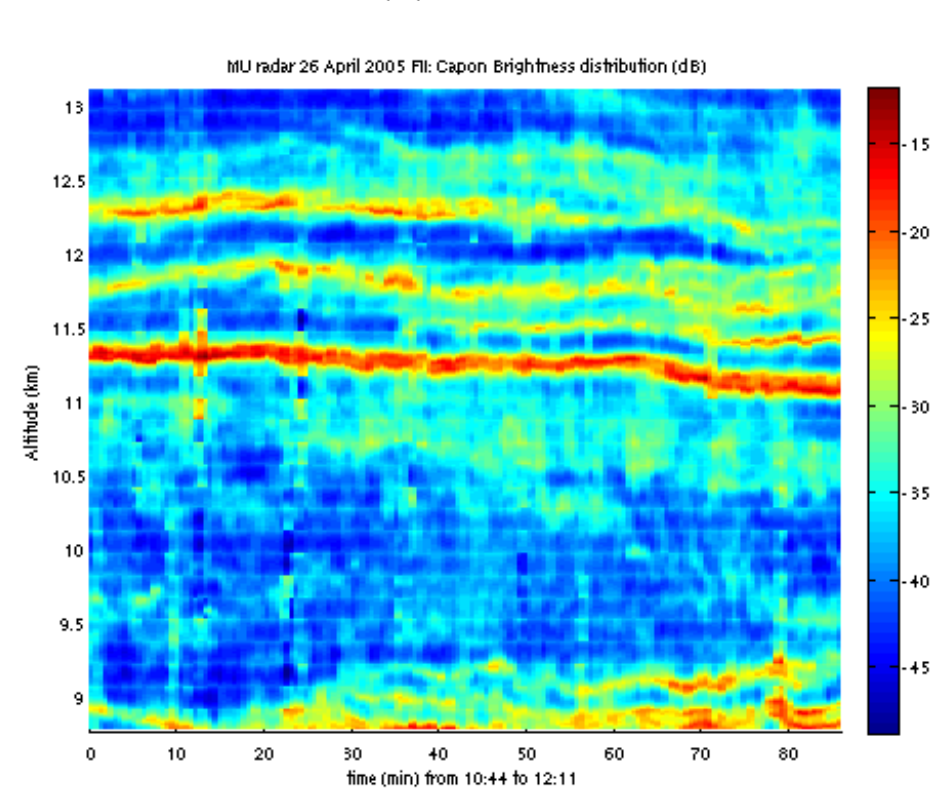
Fig. 2. Same as Fig. 1 for 8.7 to